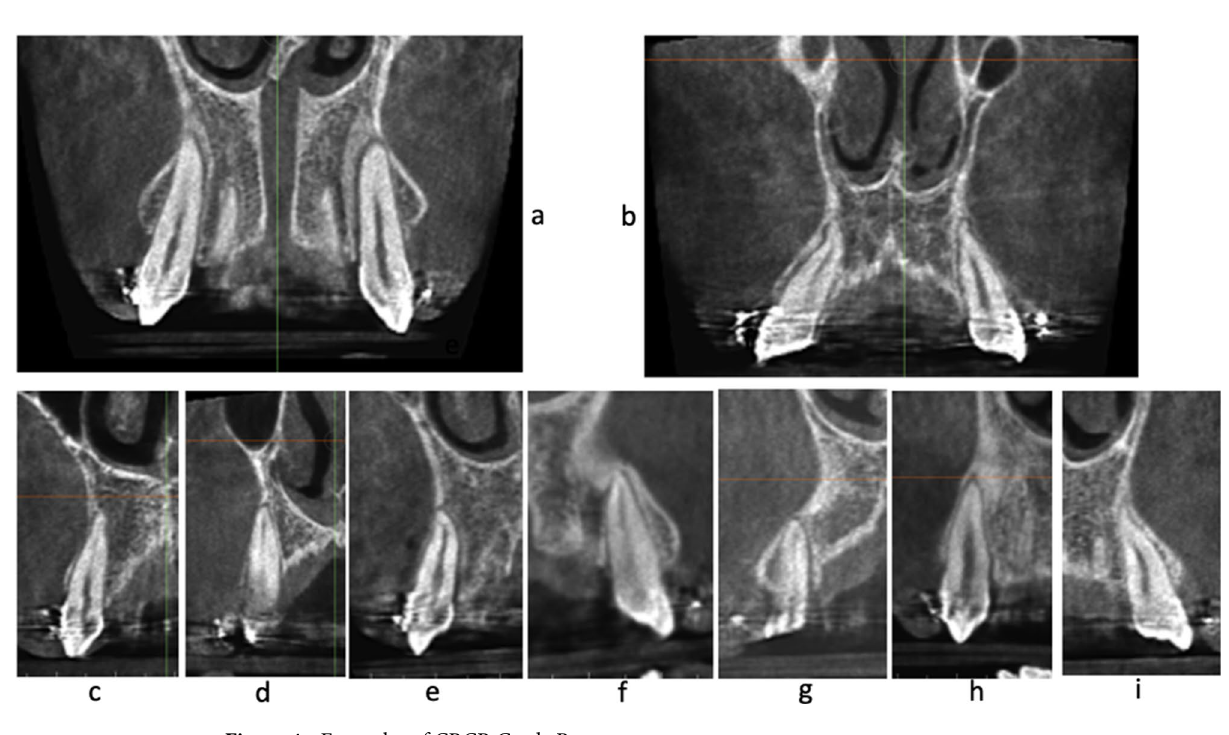
Figure 4. Examples of CRCR Grade